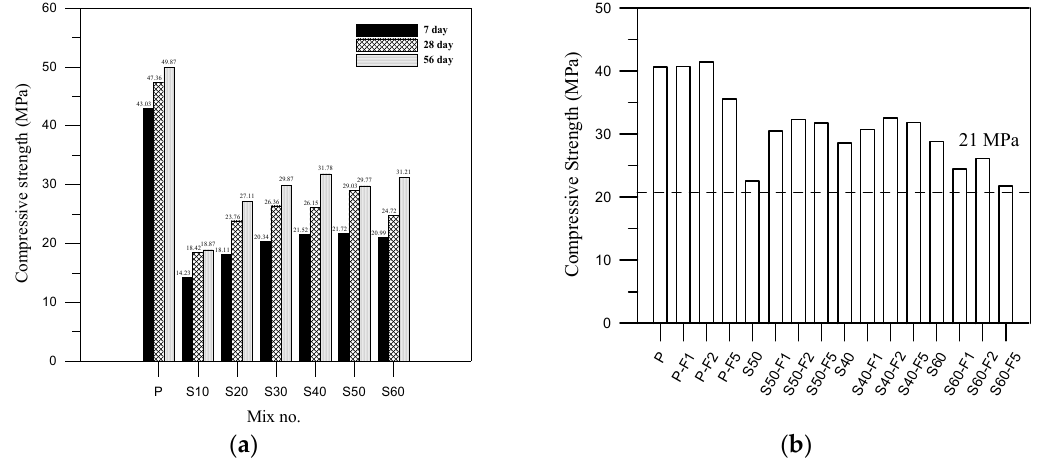
Figure 4. ( a ) Histogram presenting compressive strength results of the preliminary test; and ( b ) compressive strength development at 28 days for all mixes.